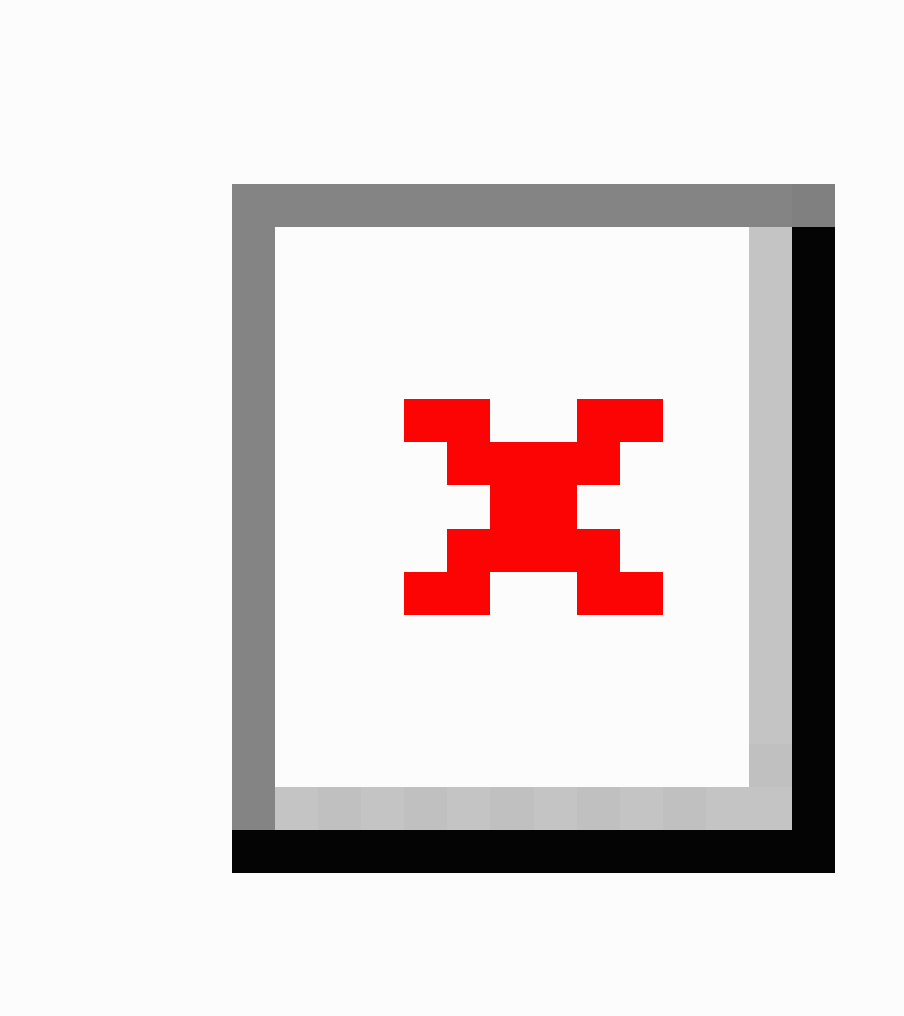
Figure 1. Example of a consumer